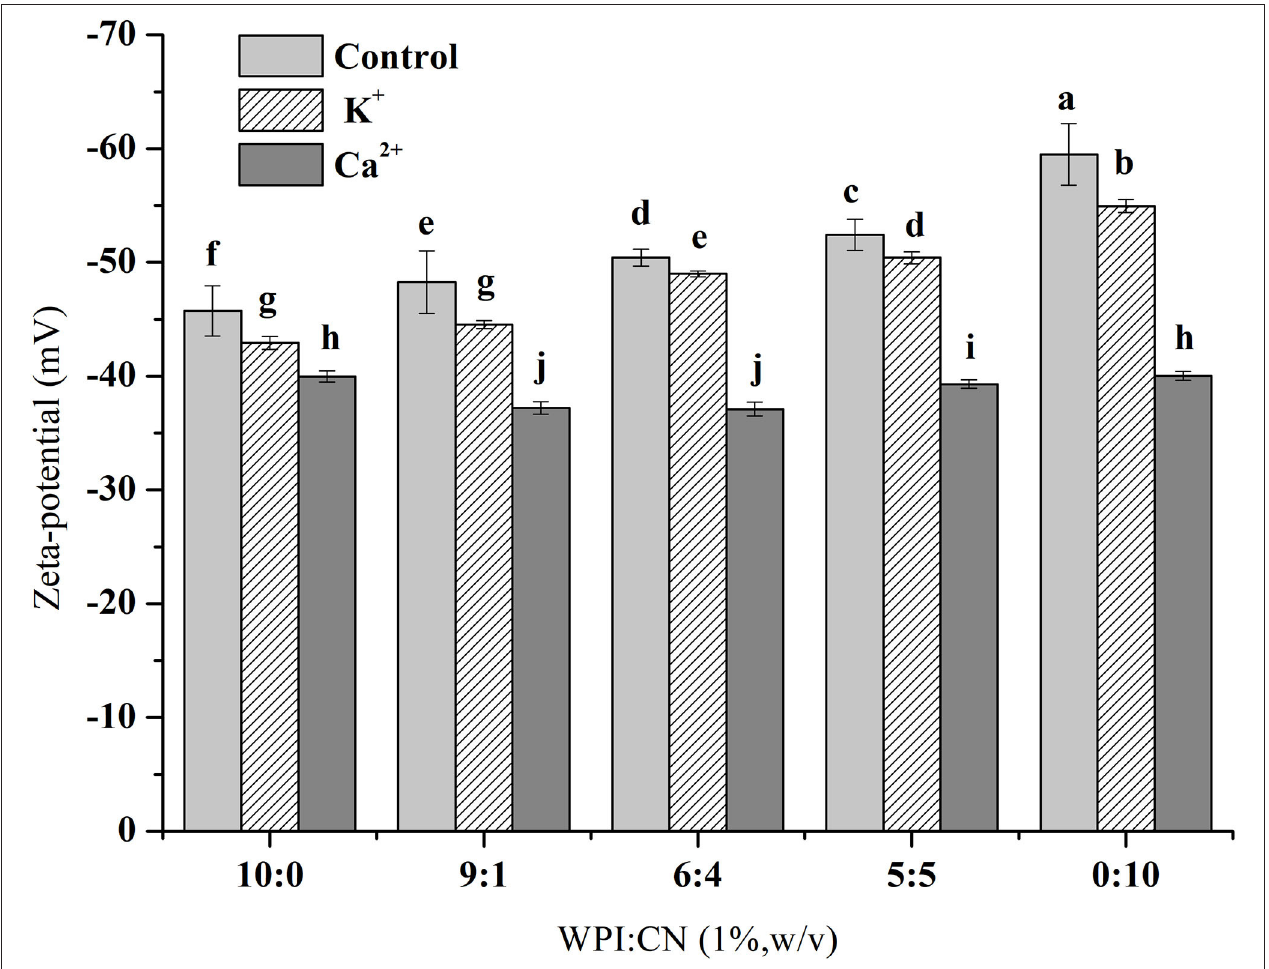
FIGURE 2 | Zeta potential of fresh OPO emulsions (10% v/v OPO human milk fat substitutes) with different ratios of WPI and CN (10:0, 9:1, 6:4, 5:5, 0:10, 1% w/v in total) as emulsifiers. The results are expressed as mean ± SD ( n = 3). Different letters (a–j) indicate significant differences at the 0.05